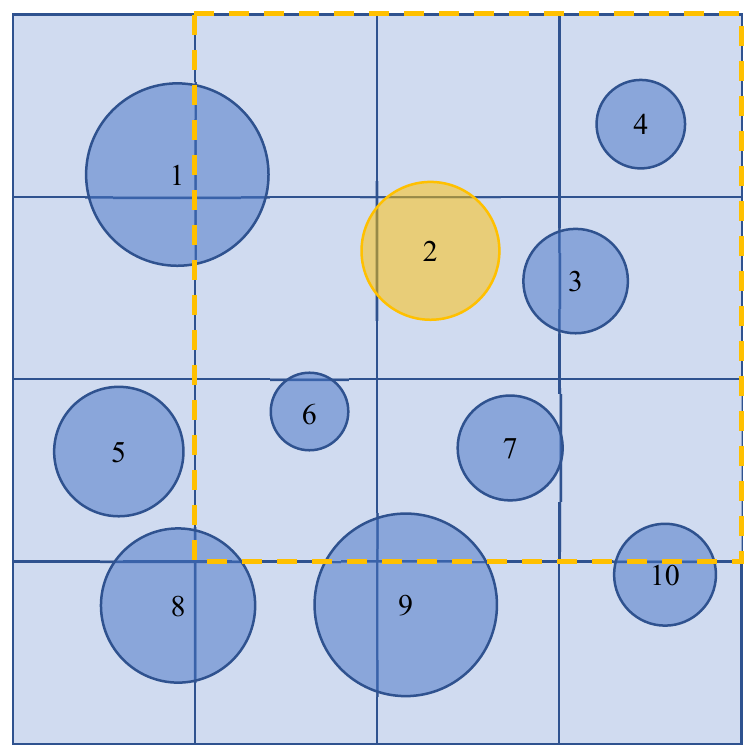
Figure 5. Illustration of overlapping detection in the 2D example. Pore 2 need to check the pores in the neighbor cubic blocks surrounded by the highlighted dash lines, that is, pore 4, 3, 6, and 7. Throat